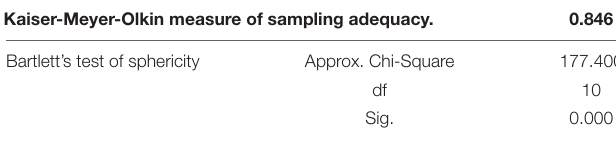
TABLE 3 | Kaiser-Meyer-Olkin (KMO) and Bartlett’s